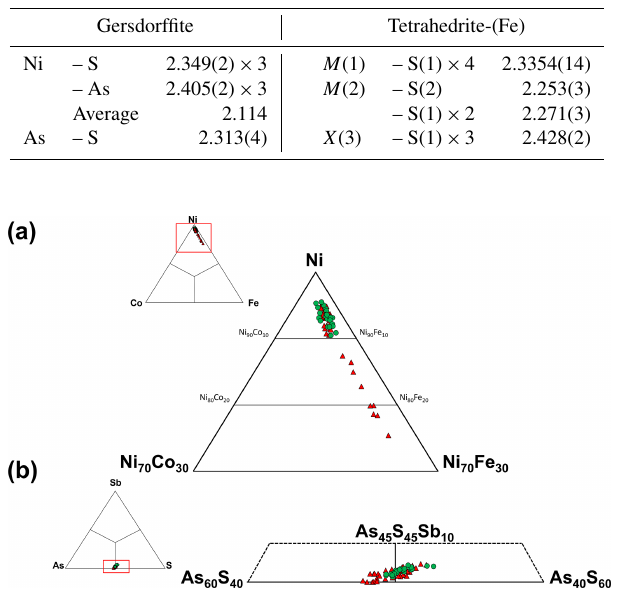
Figure 4. Compositional diagrams showing the chemical variabil- ity of gersdorffite from the Contrada Zillì. Green circles represent spot analyses performed in crystal cores, whereas red triangles cor- respond to crystal rims.